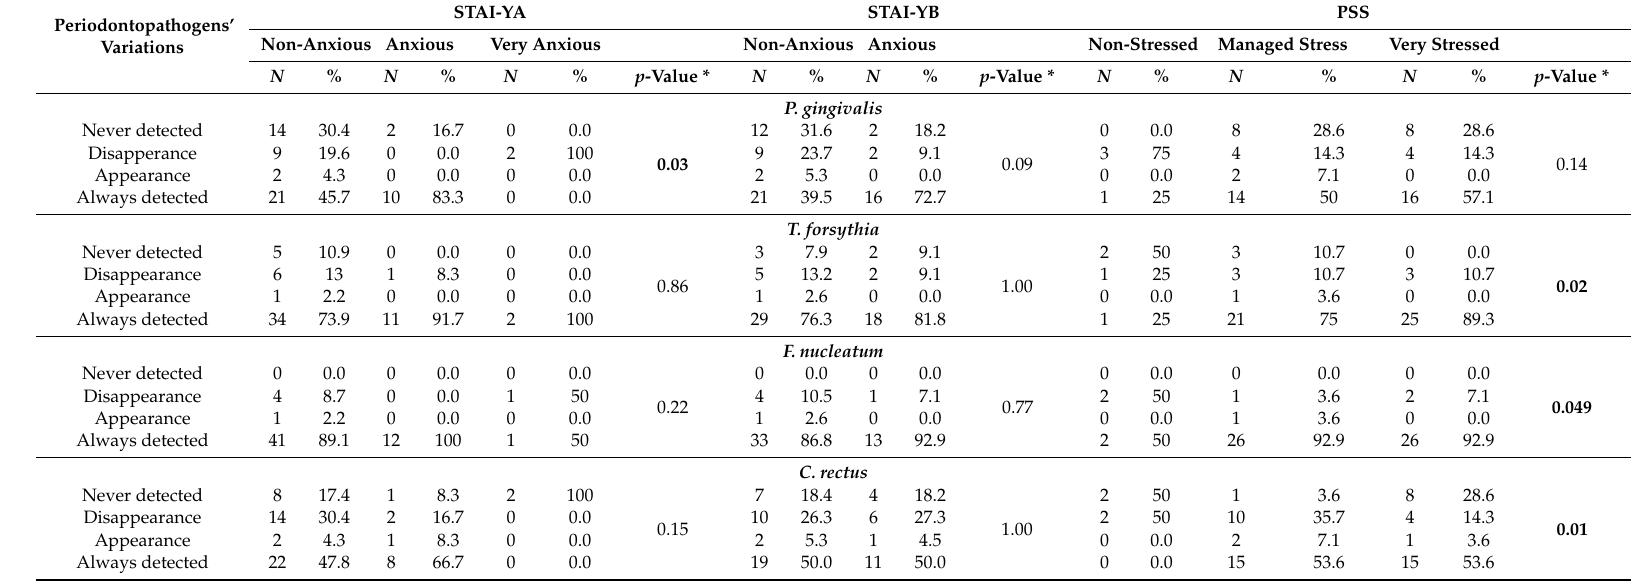
Table 6. E ff ect of stress and anxiety on the detection of some periodontal bacteria before and after SRP treatment from diseased patients. Periodontopathogens’ Variations